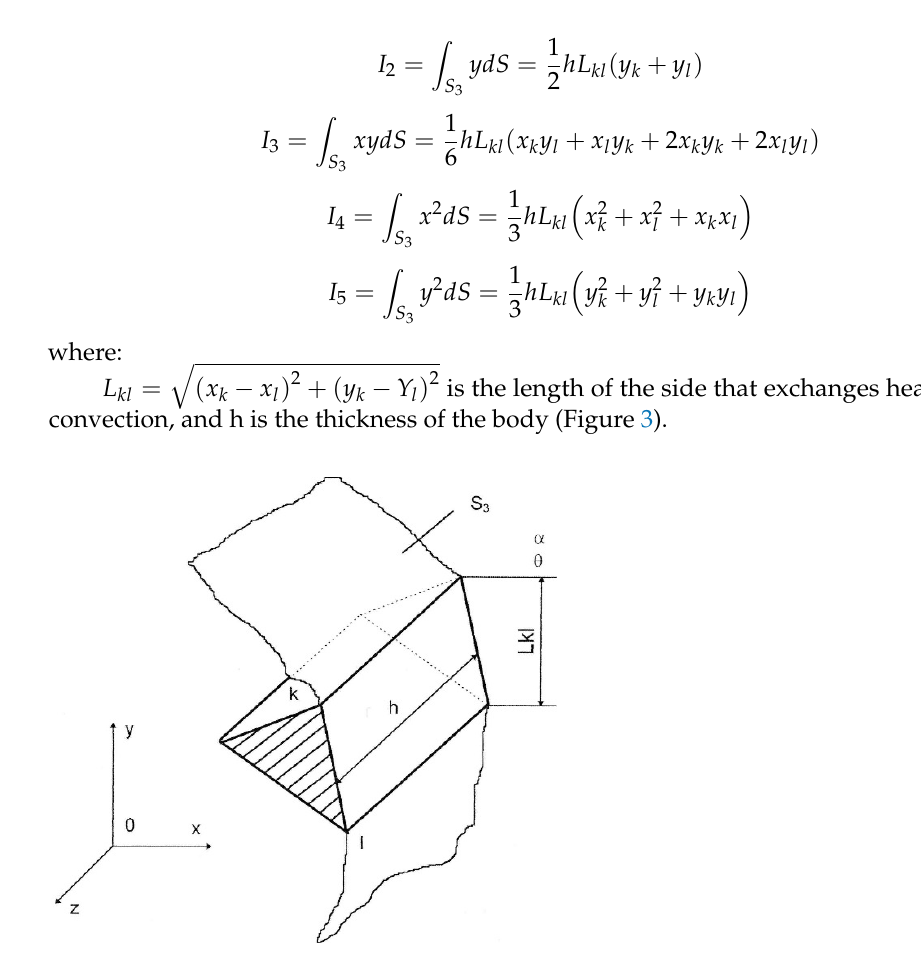
Figure 3. Triangular finite element with constant thickness h in the z-axis direction, having heat exchange by convection through the surface h × L kl , where L kl is the thickness on the y-axis direction, k and l are the dimensions in the section of the triangulated finite element. The left member of Equation (7) is the first line of the matrix [ k ] e of the element. The other lines are obtained analogously by making ∂ J the end the left member becomes